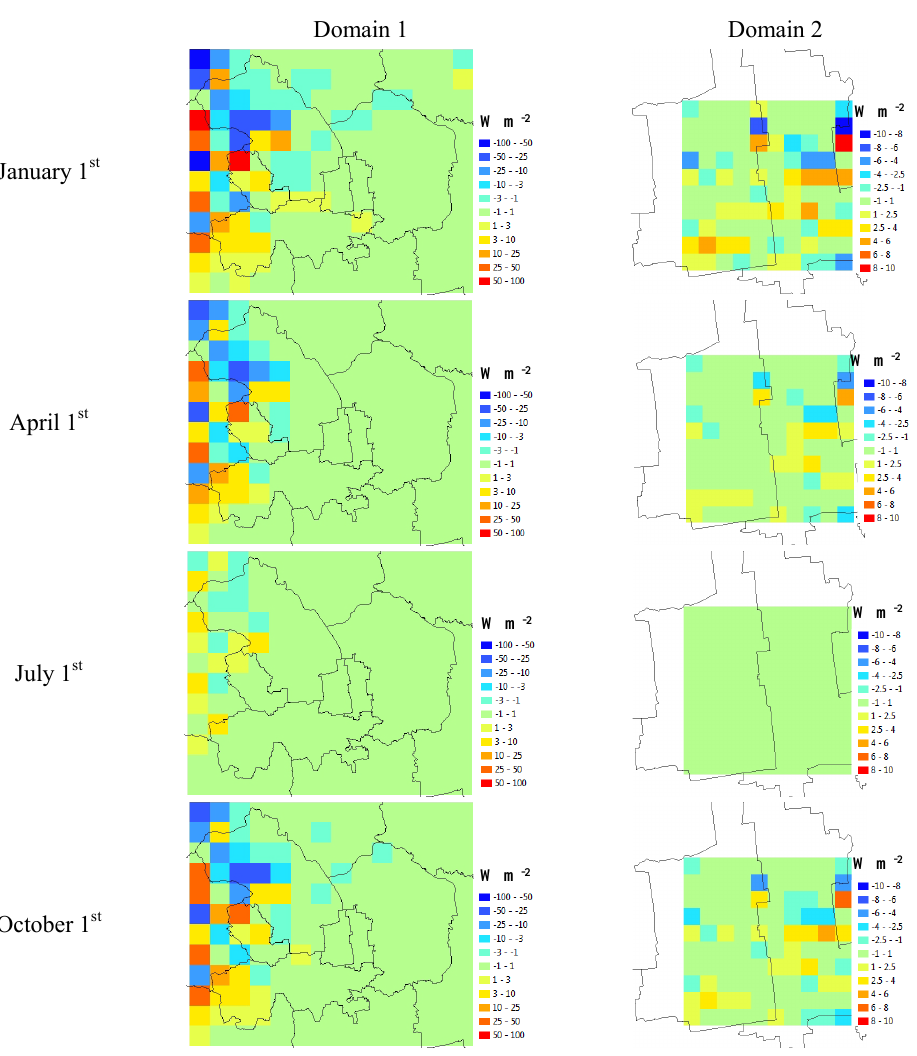
Figure 3. Daily average surface solar flux deviations between the 3-D radiation parameterization and the plane-parallel scheme in clear-sky condition without aerosols on 1 January, 1 April, 1 July, and 1 October